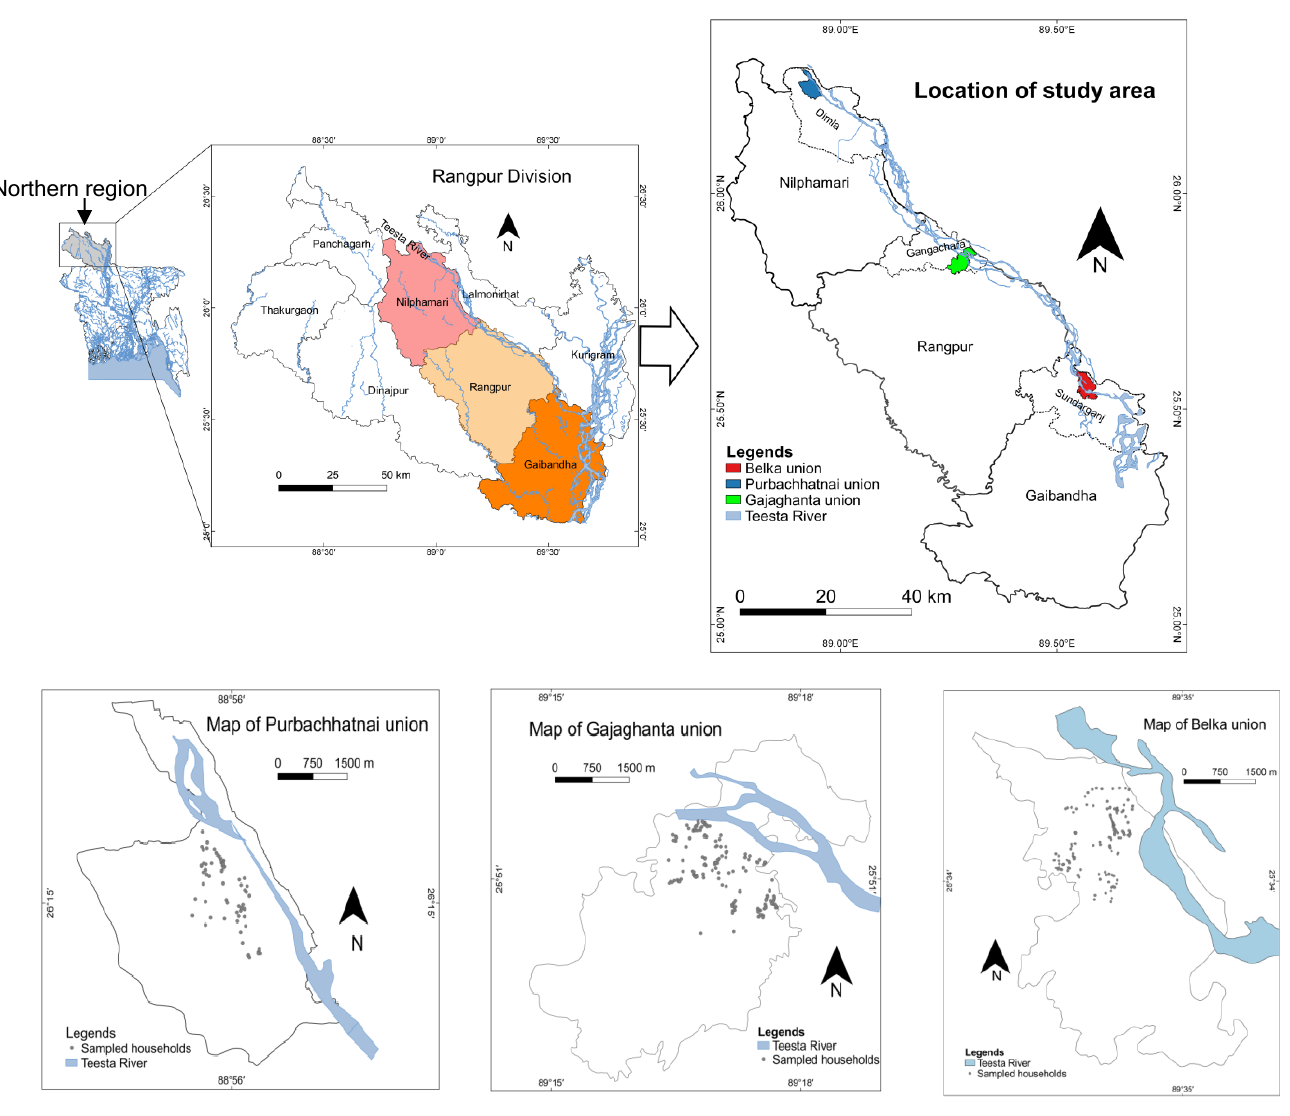
Figure 1. Map of the study area.